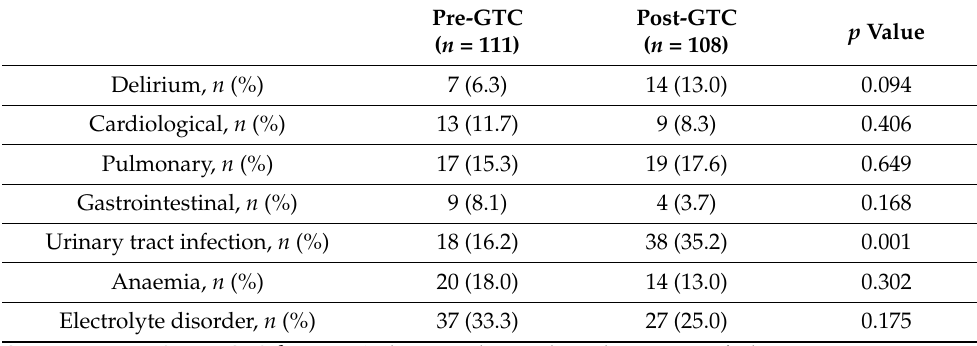
Table 3. New in-hospital findings and diagnoses upon patient admission a .